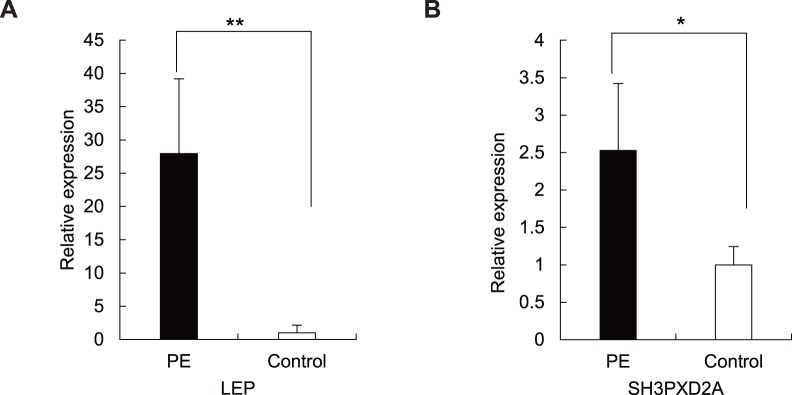
Validation the mRNA expression of LEP and SH3PXD2A in preeclamptic (n = 7) versus normal (n = 6) placentas.(A) Expression of LEP mRNA measured by qRT-PCR. The difference between preeclamptic placentas and normal controls is highly significant (p = 0.003). **p<0.01. Each bar represents the average relative expression compared with GAPDH. The average mRNA level of LEP and SH3PXD2A in healthy controls was defined as 1. (B) Expression of SH3PXD2A mRNA quantified by qRT-PCR. The expression of SH3PXD2A is significantly elevated in placentas from pregnancies with PE (p = 0.024). *p<0.05. Each bar represents the average relative expression compared with GAPDH. The average mRNA level of SH3PXD2A in healthy controls was defined as 1.